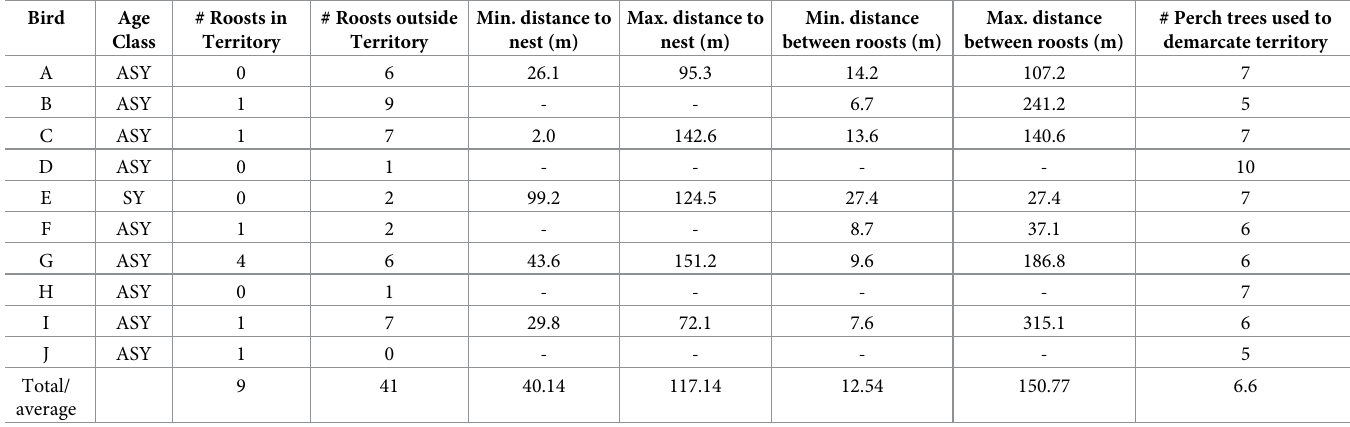
Table 1. Cerulean Warbler roost site characteristics. Cerulean Warbler ( Setophaga cerulea , Wilson) roost site statistics in southern Indiana, May-June